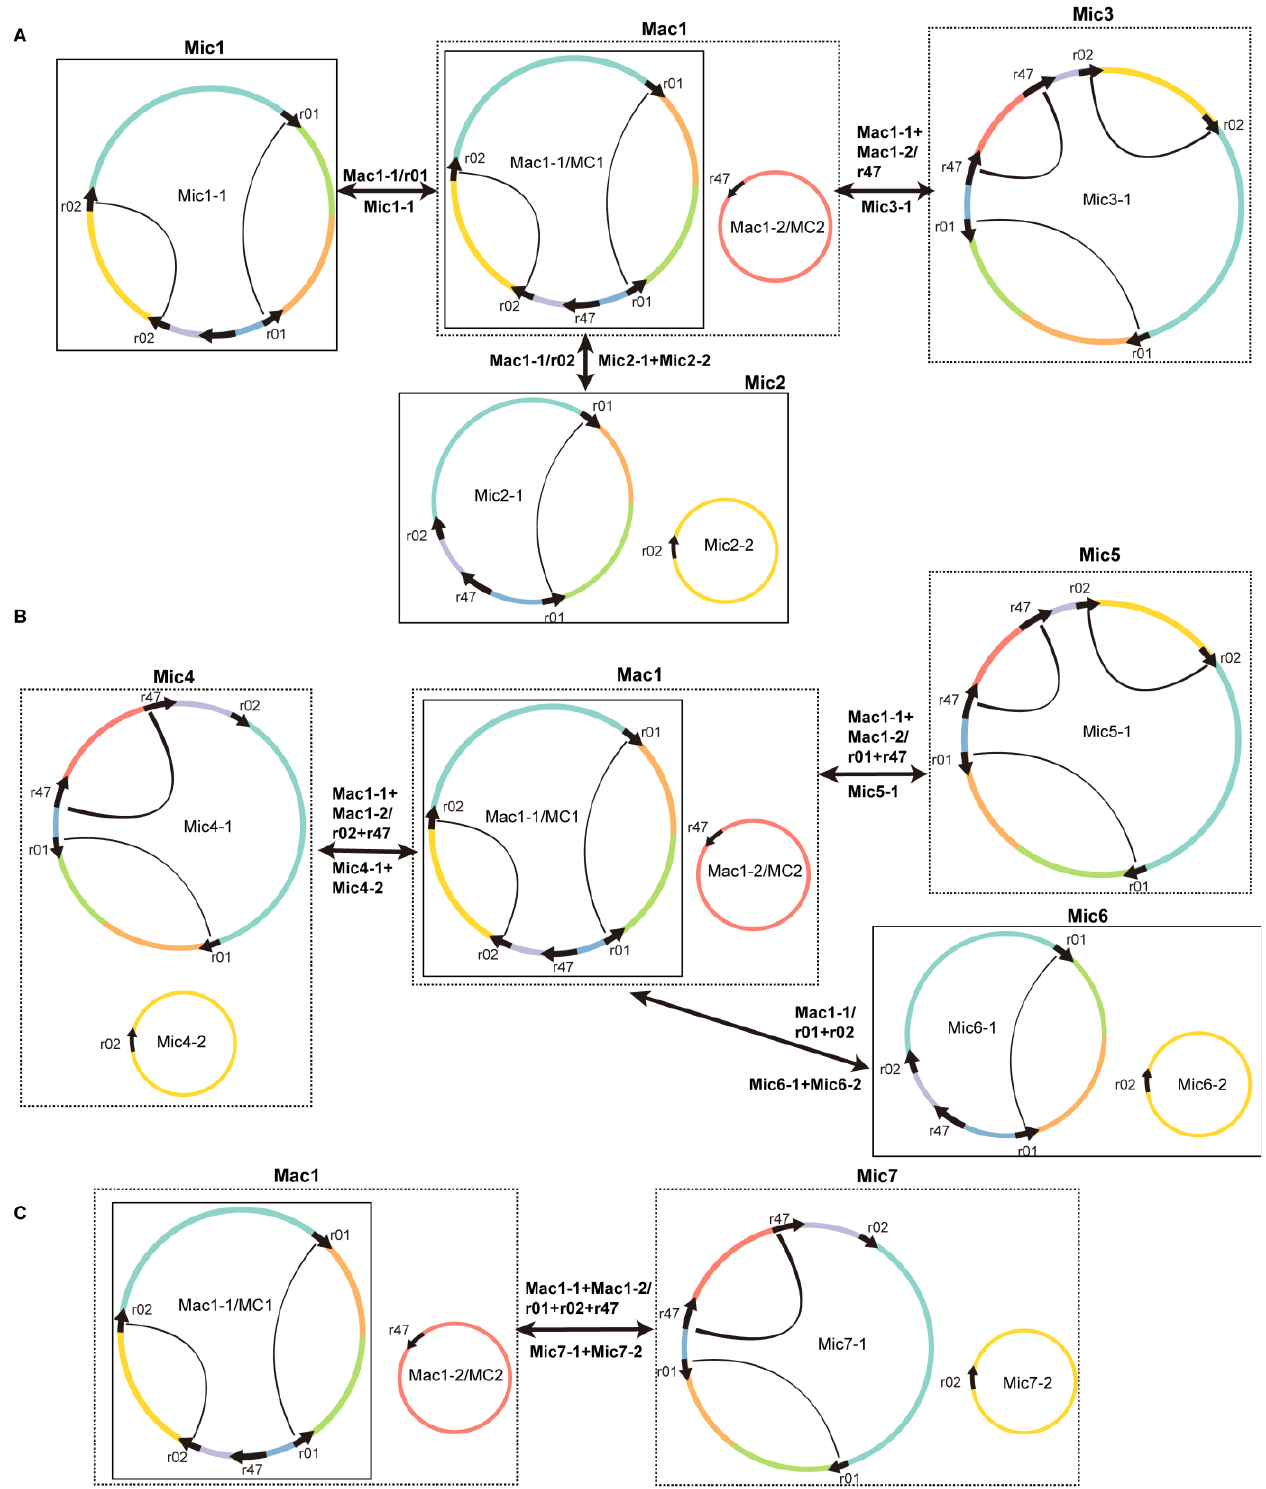
Figure 7. Products of homologous recombination mediated by one ( A ), two ( B ), and three ( C ) of the repetitive sequences r01, r02, and r47. The repeat units of r01, r02, and r47 are represented by arrows. The two repeat units are connected with arcs if they are on the same chromosome. Sequences around the repeat units are shown in different colors. The circles represent circular chromosomes. The genomic conformation is named “c” followed by the conformation number. In contrast, the circular chromosomes of a particular genomic conformation are named “ c ” followed by the conformation number, “ - ” , and the chromosome number. The double-headed arrows indicated the source circular chromosomes, the repetitive elements, and the product circular chromosomes, separated with “/” .